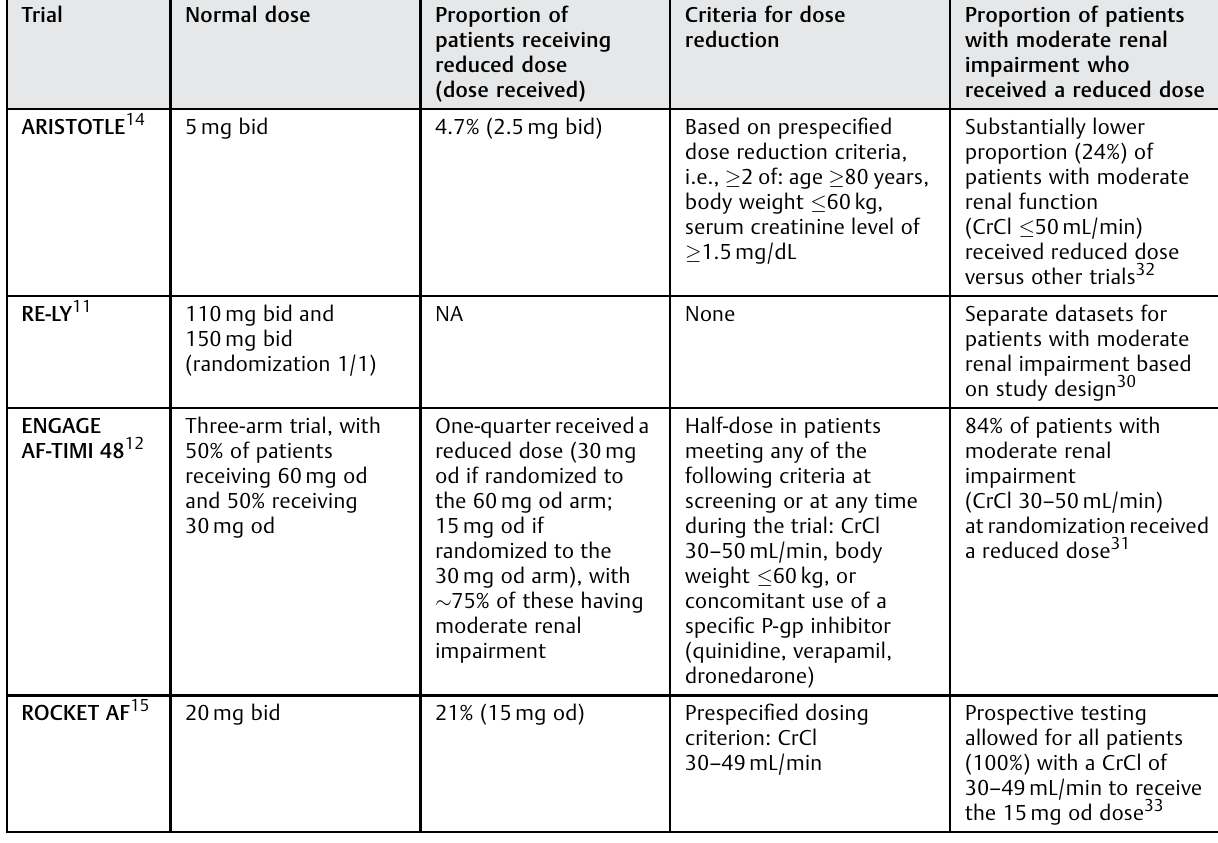
Table 2 Proportion of patients receiving a reduced dose of NOAC across phase III stroke prevention trials